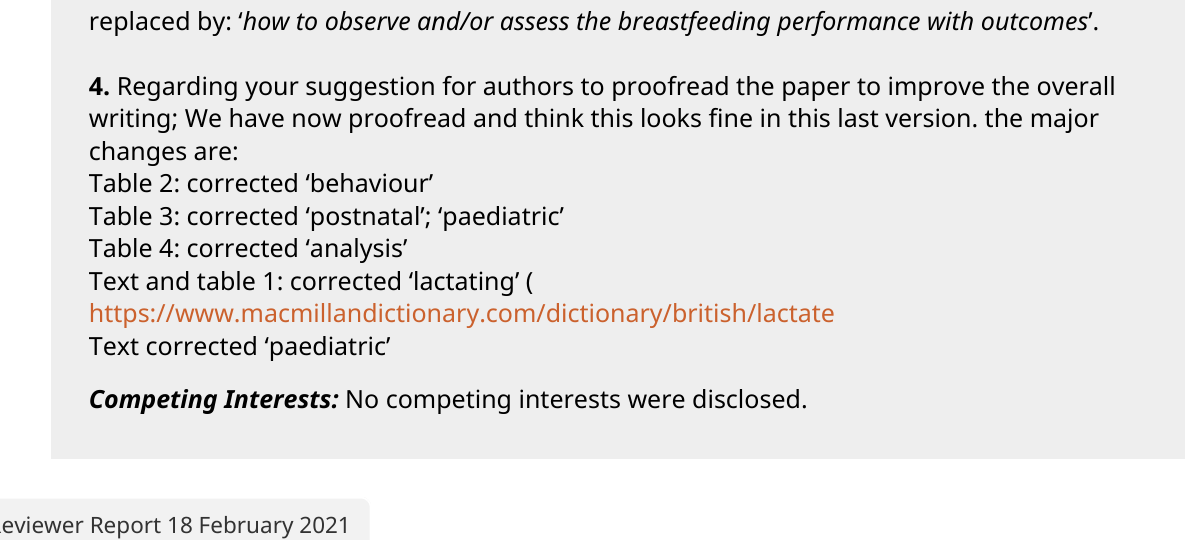
Table 2: corrected ‘behaviour’ Table 3: corrected ‘postnatal’; ‘paediatric’ Table 4: corrected ‘analysis’ Text and table 1: corrected ‘lactating’